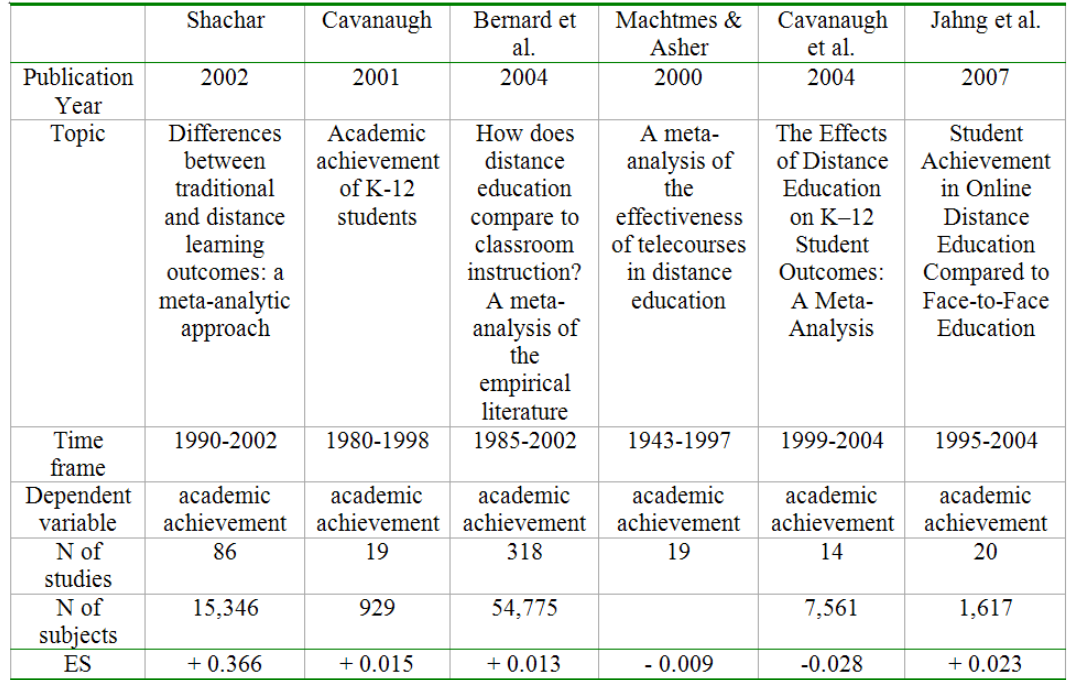
Table 1. Meta-Analyses in Recent DE